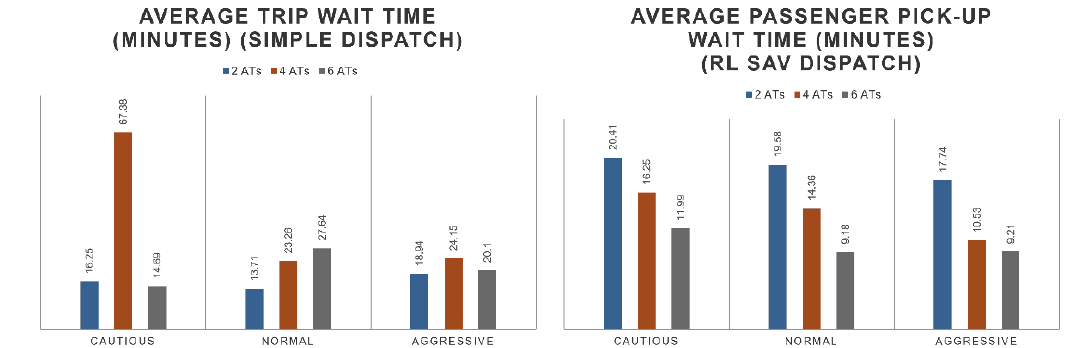
Figure 21. Wait time of simple dispatcher vs. SAV dispatcher.